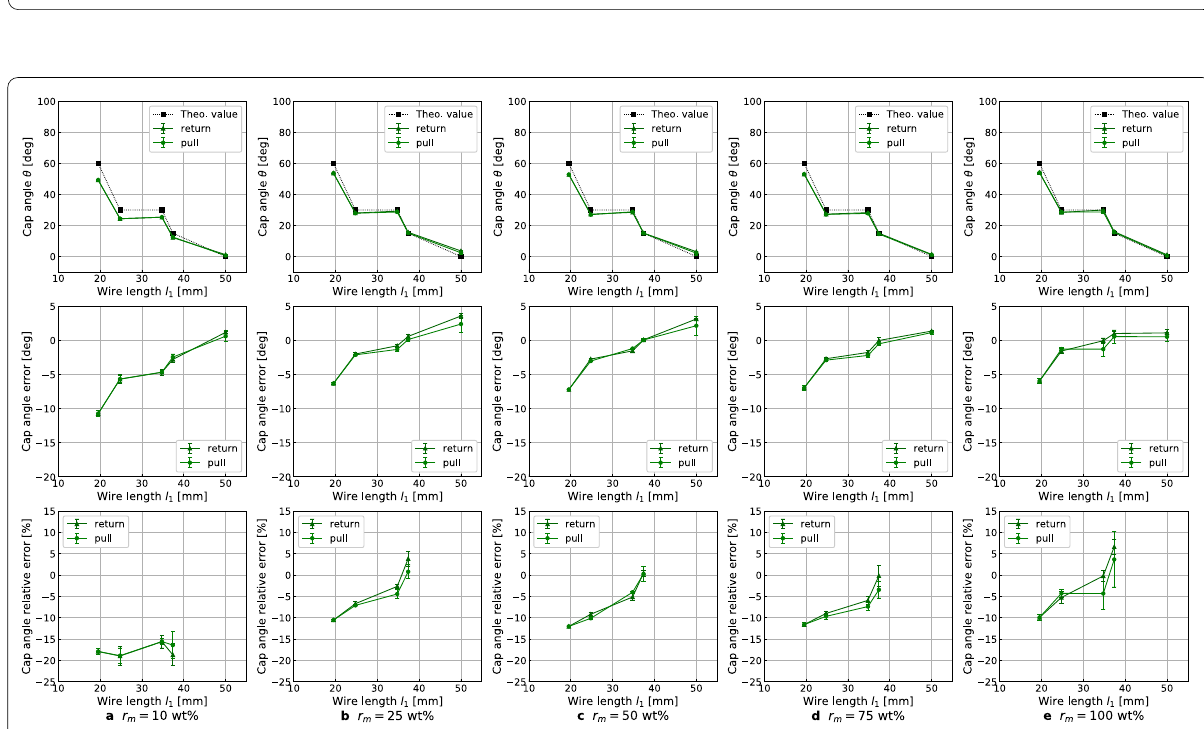
Fig. 15 Cap angle θ (top), its error (middle), and relative error (bottom) to wire length l 1 for each plasticizer mixing ratio in deformation pattern (b). Each plot represents the mean value of the three times. The error bars represent the standard